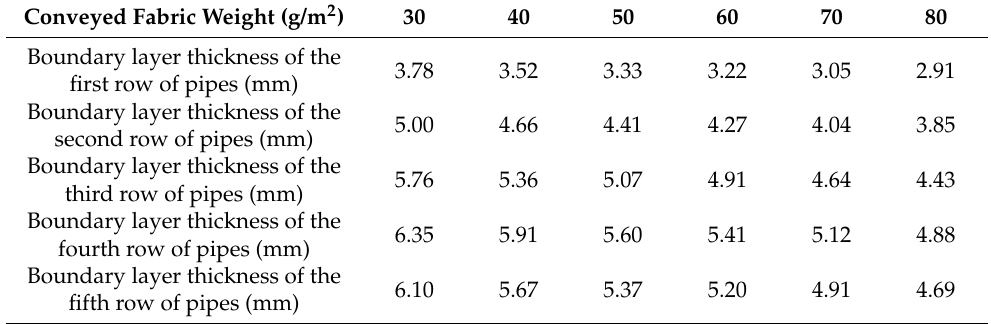
Table 6. Boundary layer thickness of the gas flowing through the lower surfaces of different fabrics.